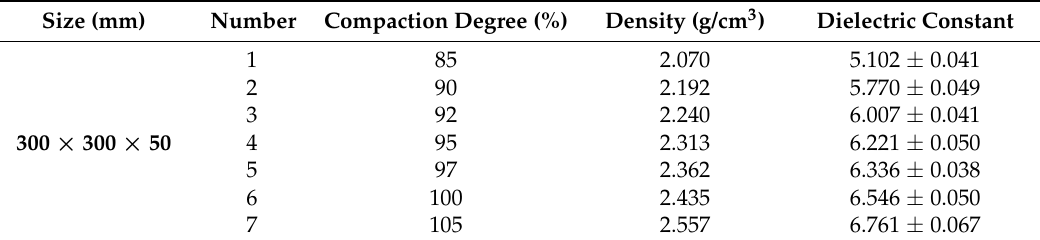
Table 1. The parameters and measured dielectric constants of lab samples.